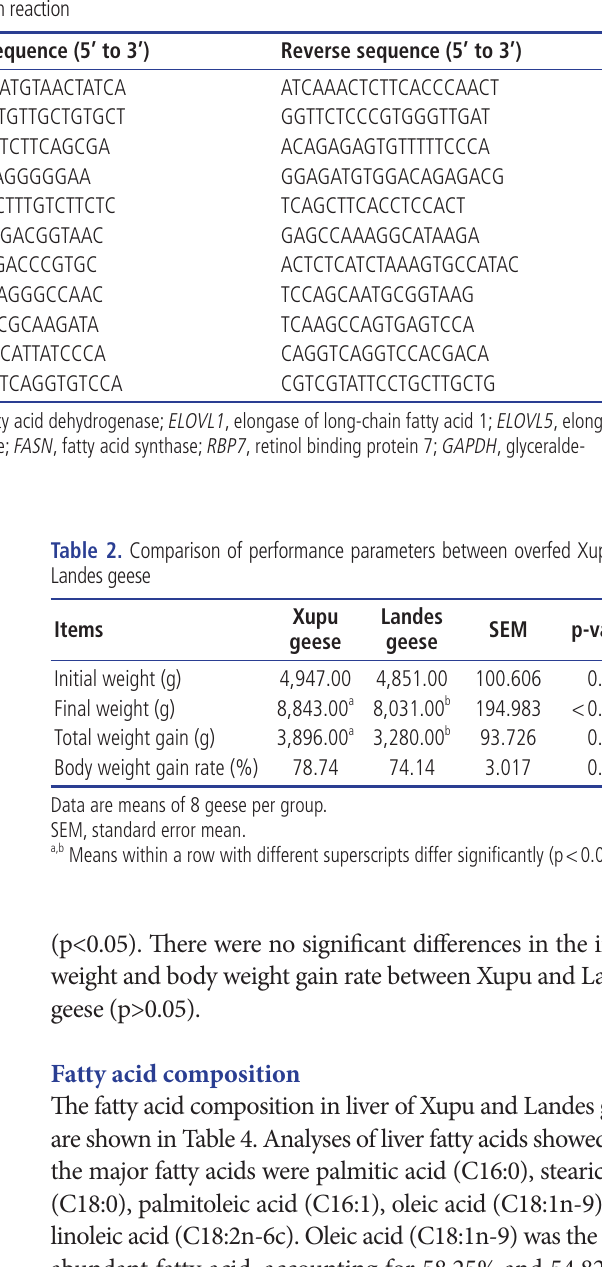
Table 1. The primers used for gene cloning, quantitative real-time polymerase chain reaction